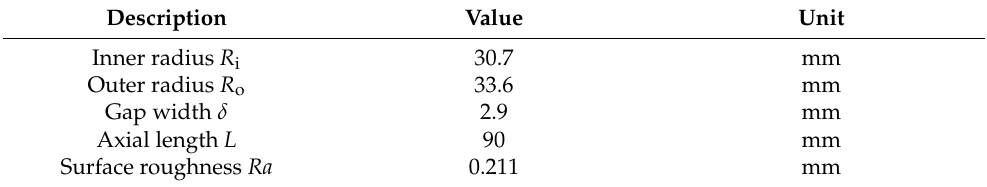
Table 2. Device’s dimensions and experimental conditions used for turbulence model validation.